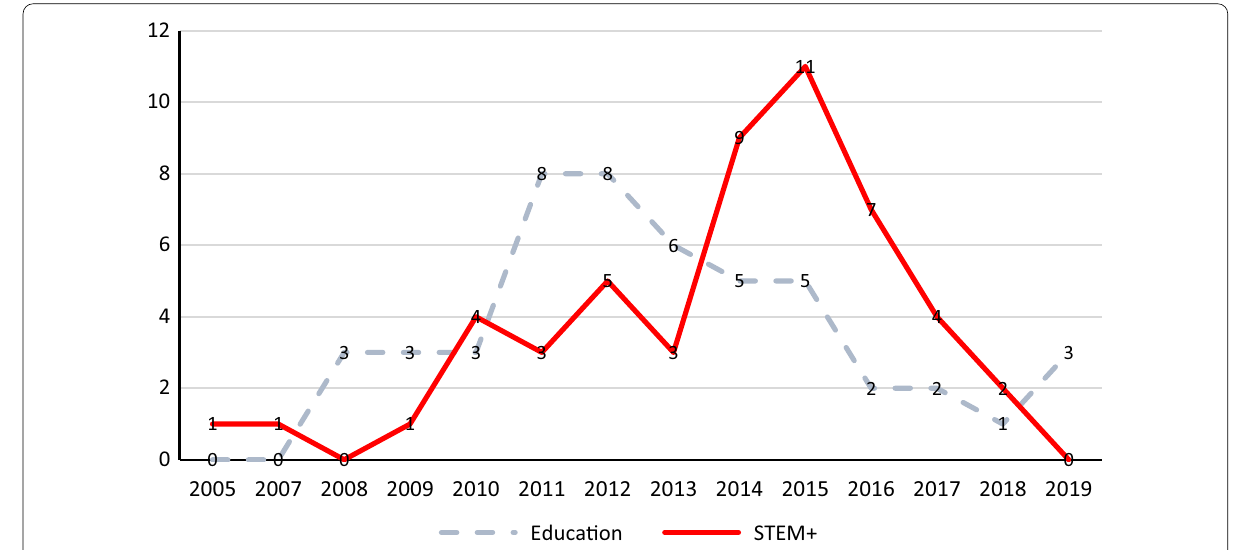
Fig. 8 Distribution of publications by corresponding author’s profession over the years. (Note: 1